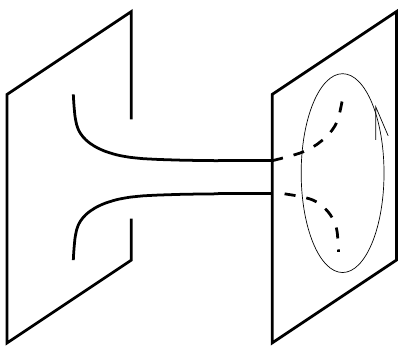
Figure 8 . Deformation of the pinched (cid:6) SW to a smooth curve that admits a circle action with no (cid:12)xed